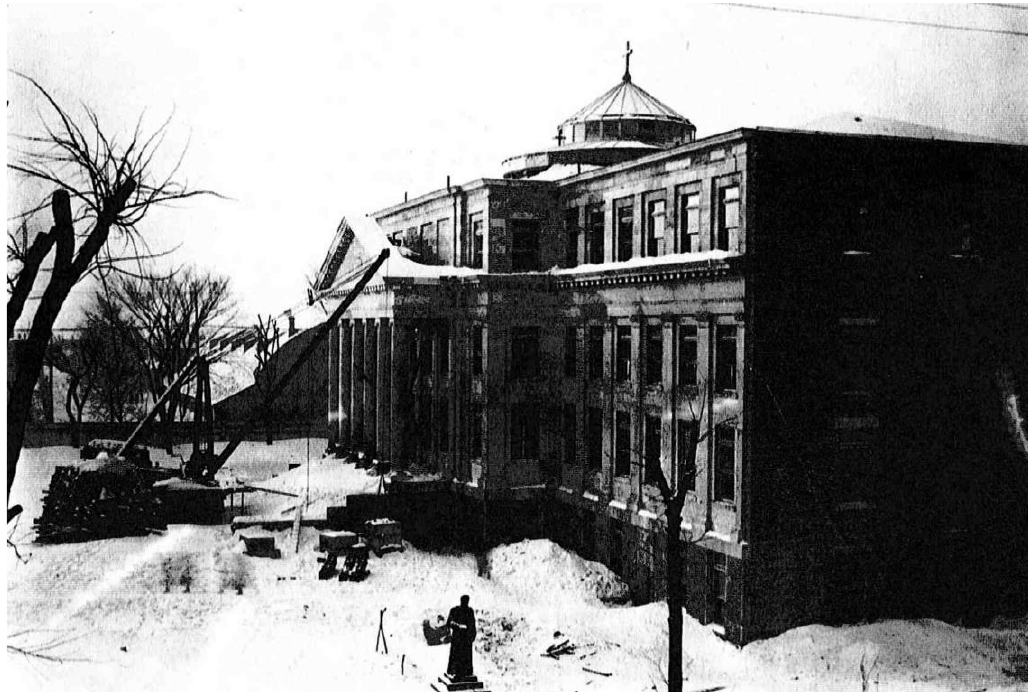
Figure 3. Photograph of Tabaret Hall from 1903.